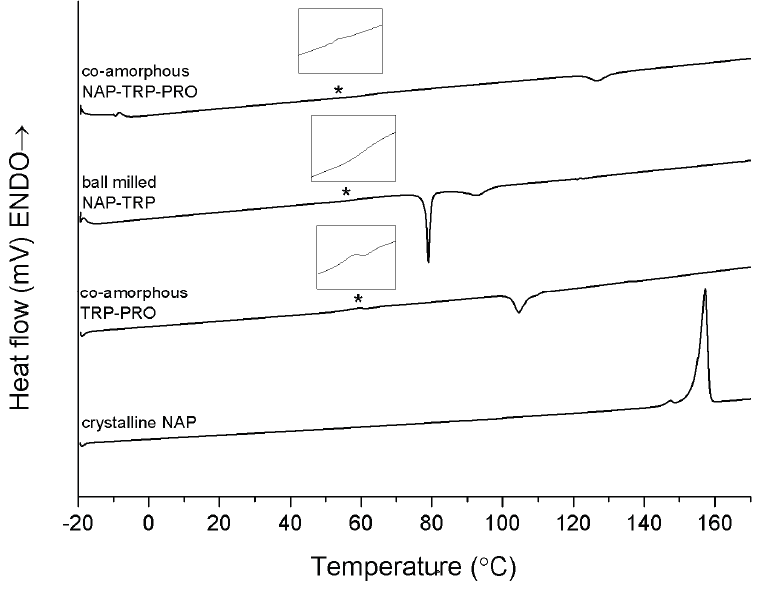
Figure 3. DSC measurements of crystalline NAP, co-amorphous TRP–PRO, ball-milled NAP–TRP and co-amorphous NAP–TRP–PRO. The T enlarged in the insert above the graph. Endothermal events